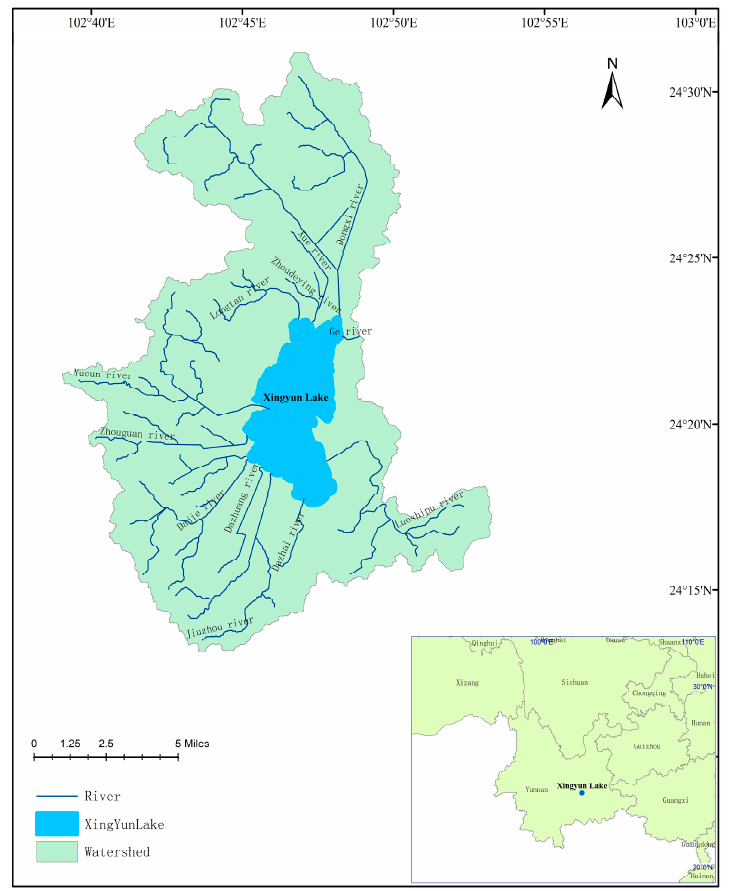
Figure 3. Location of Xingyun Lake and watershed.